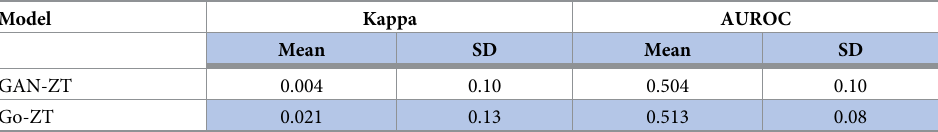
Table 4. Model performance using shuffled